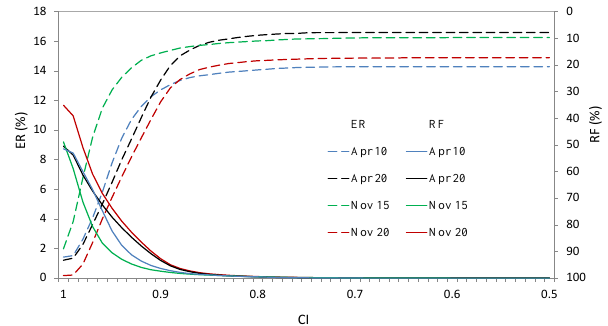
Figure 10. Trade-off between erroneous reconstruction (ER, dashed lines) and reconstruction fraction (RF, solid lines) after step 4 as a function of